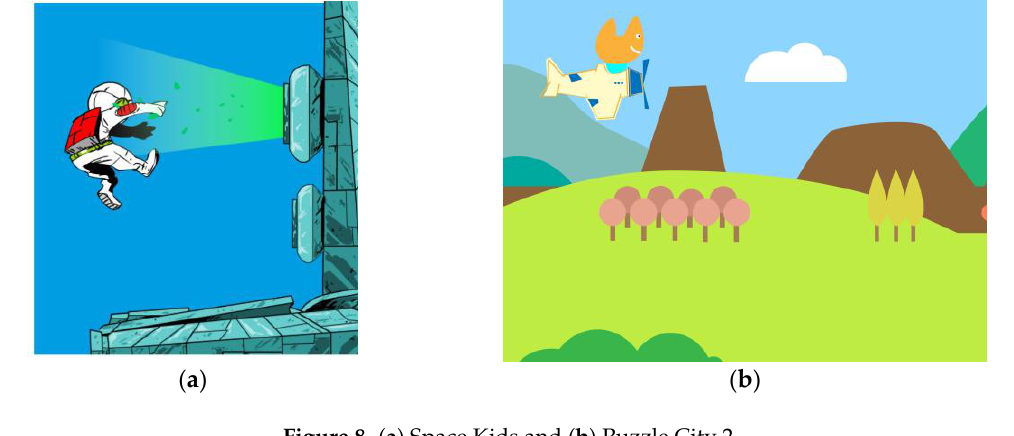
Table 1. Technical specifications and other characteristics for the different versions of the system.